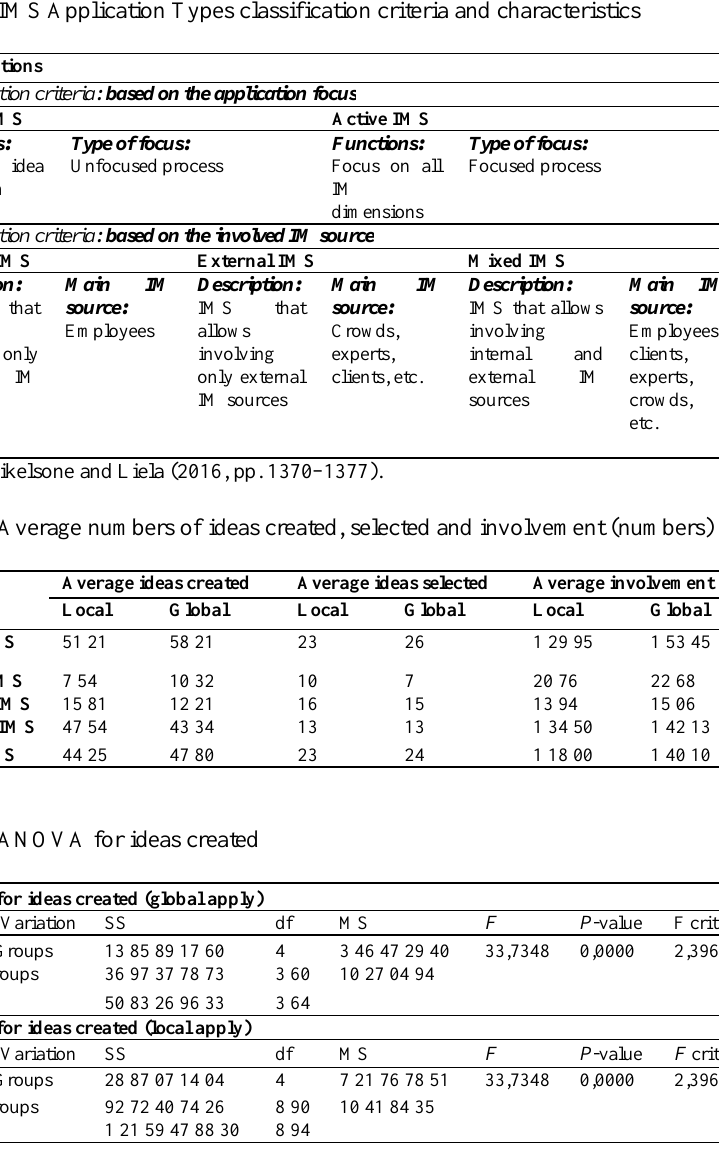
Table 1. IMS Application Types classification criteria and characteristics